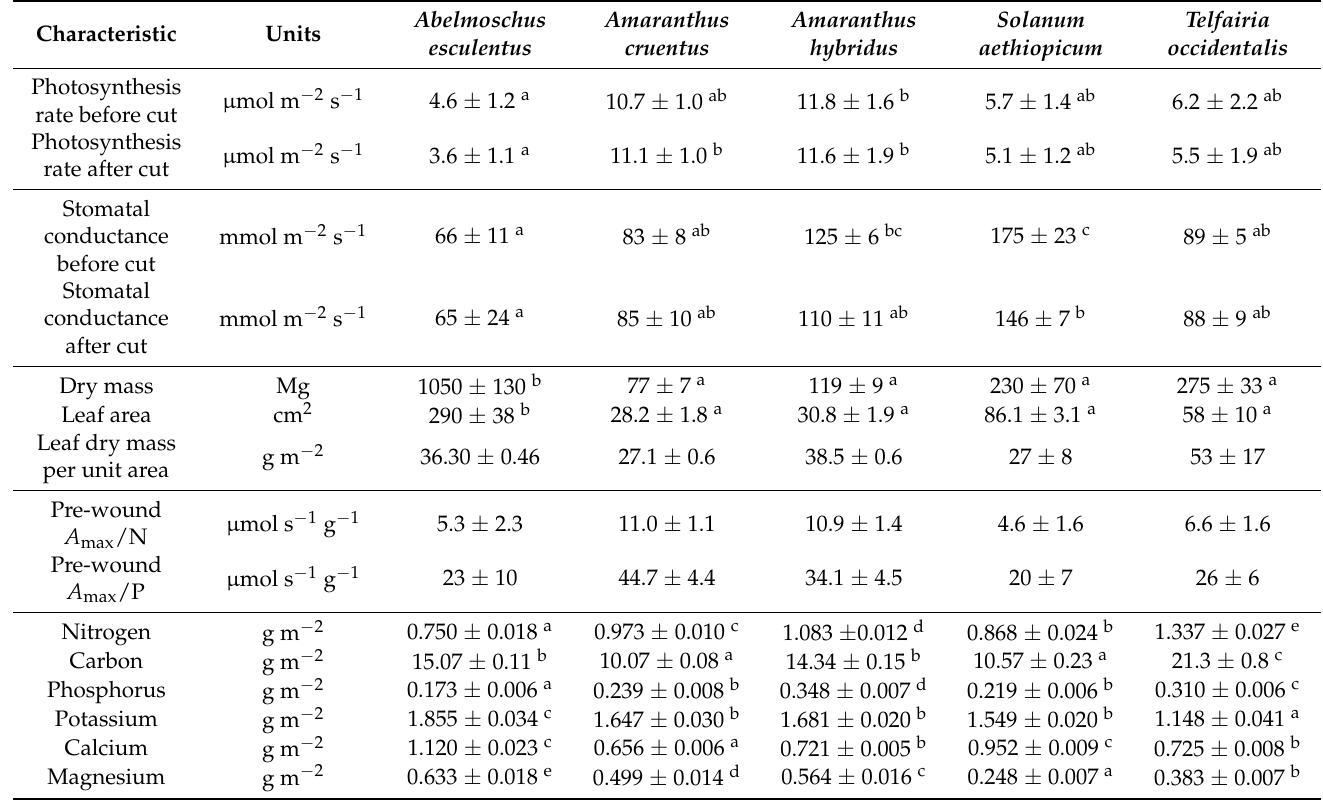
Table 1. Average ± SE (standard error) leaf photosynthetic and structural characteristics and contents of macroelements.